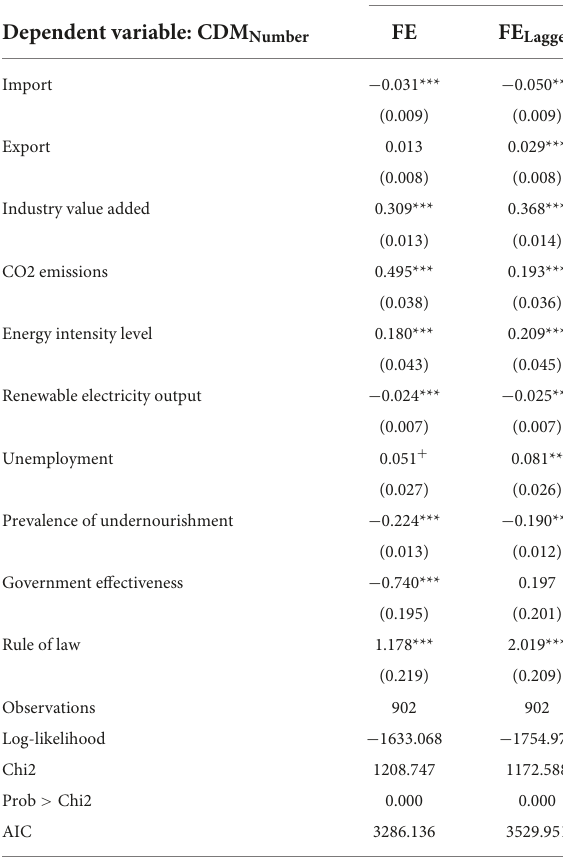
TABLE 6 Panel Poisson regression